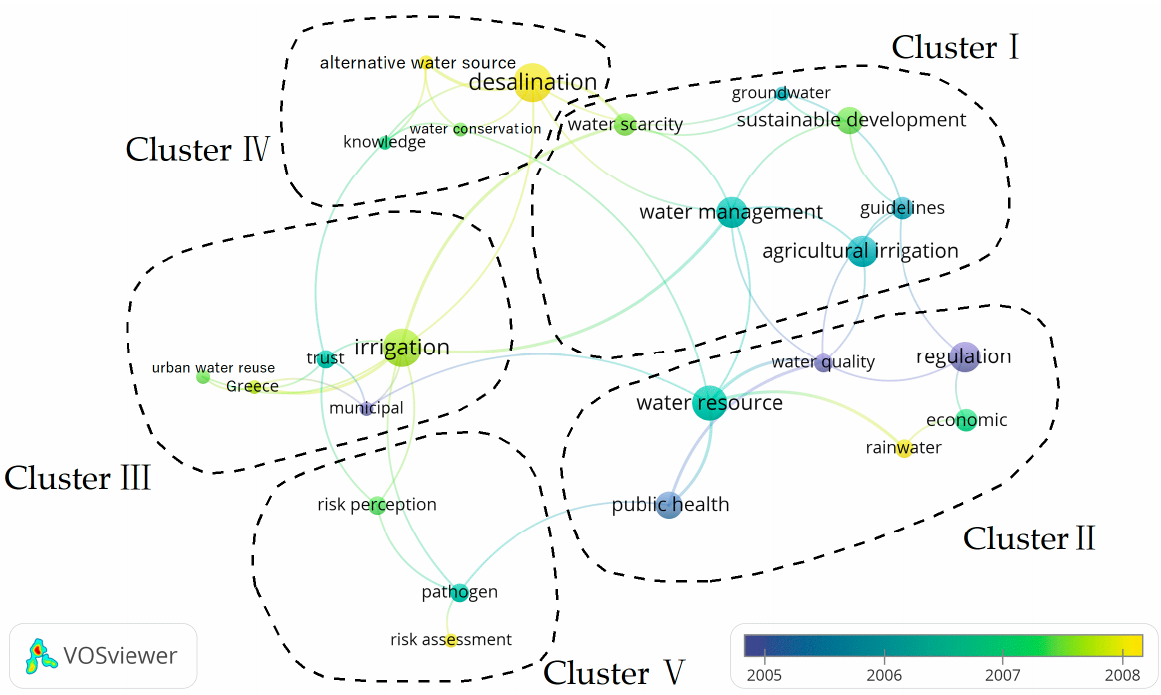
Figure 4. Keyword co-occurrence networks and clusters from 2001 to 2010.